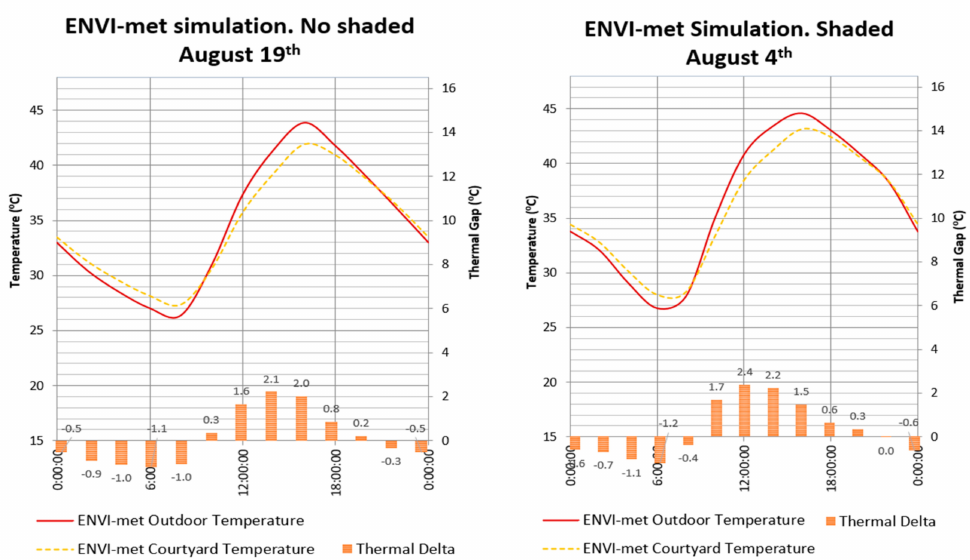
Figure 5. ENVI-met-simulated outdoor and courtyard air temperatures on the selected